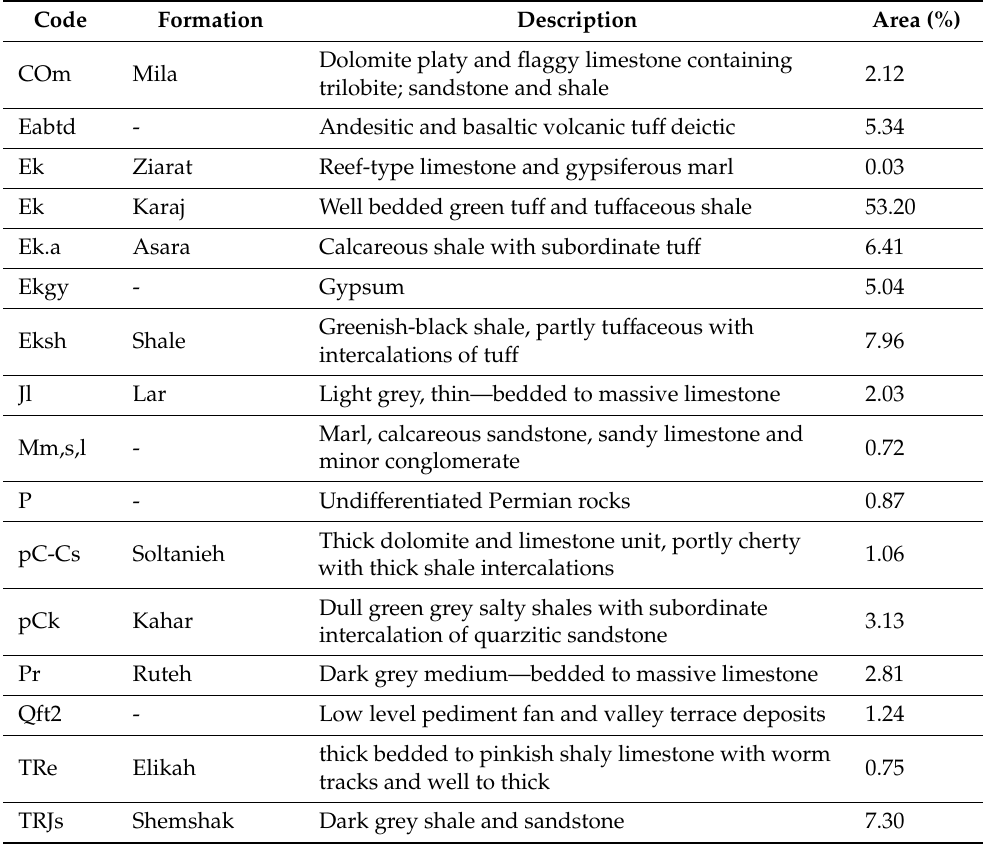
Table 1. Geology of the study area.